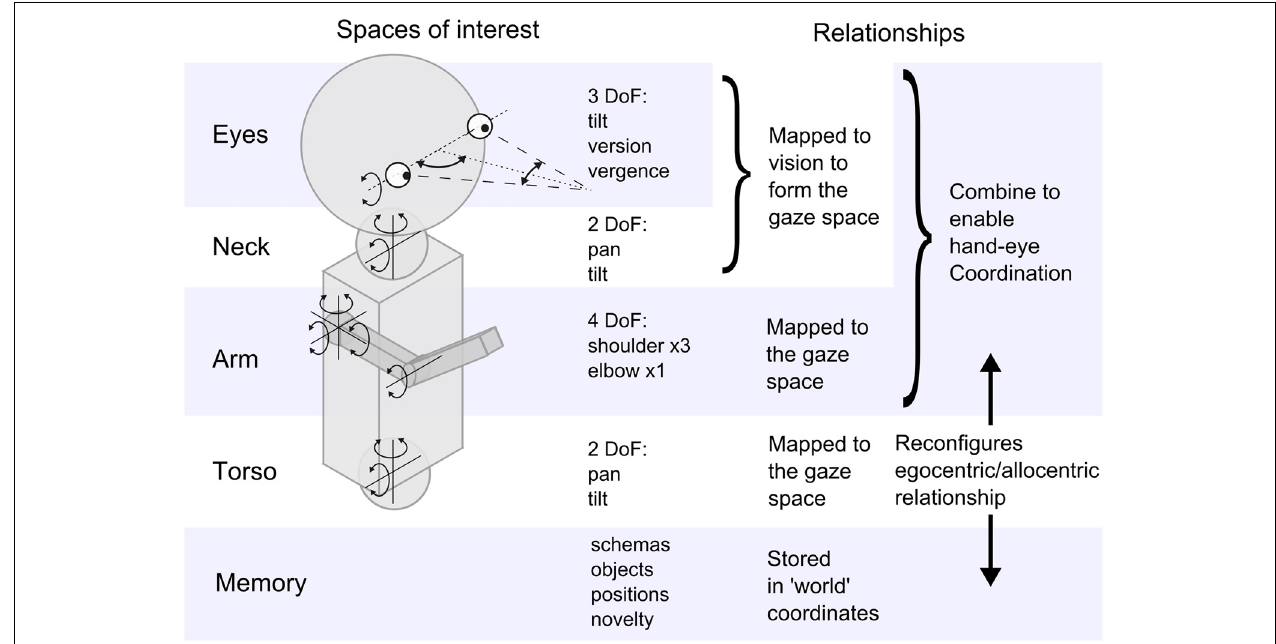
FIGURE 2 | A schematic representation of the iCub highlighting the sensorimotor spaces explored in the experiment, and the relationships between